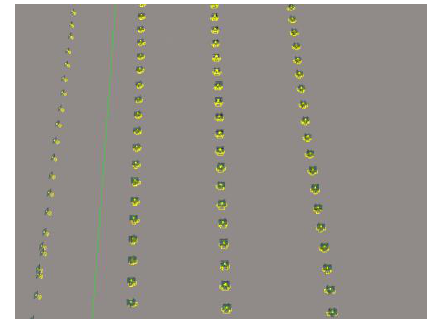
Figure 4 The flight trajectory in experimentation area